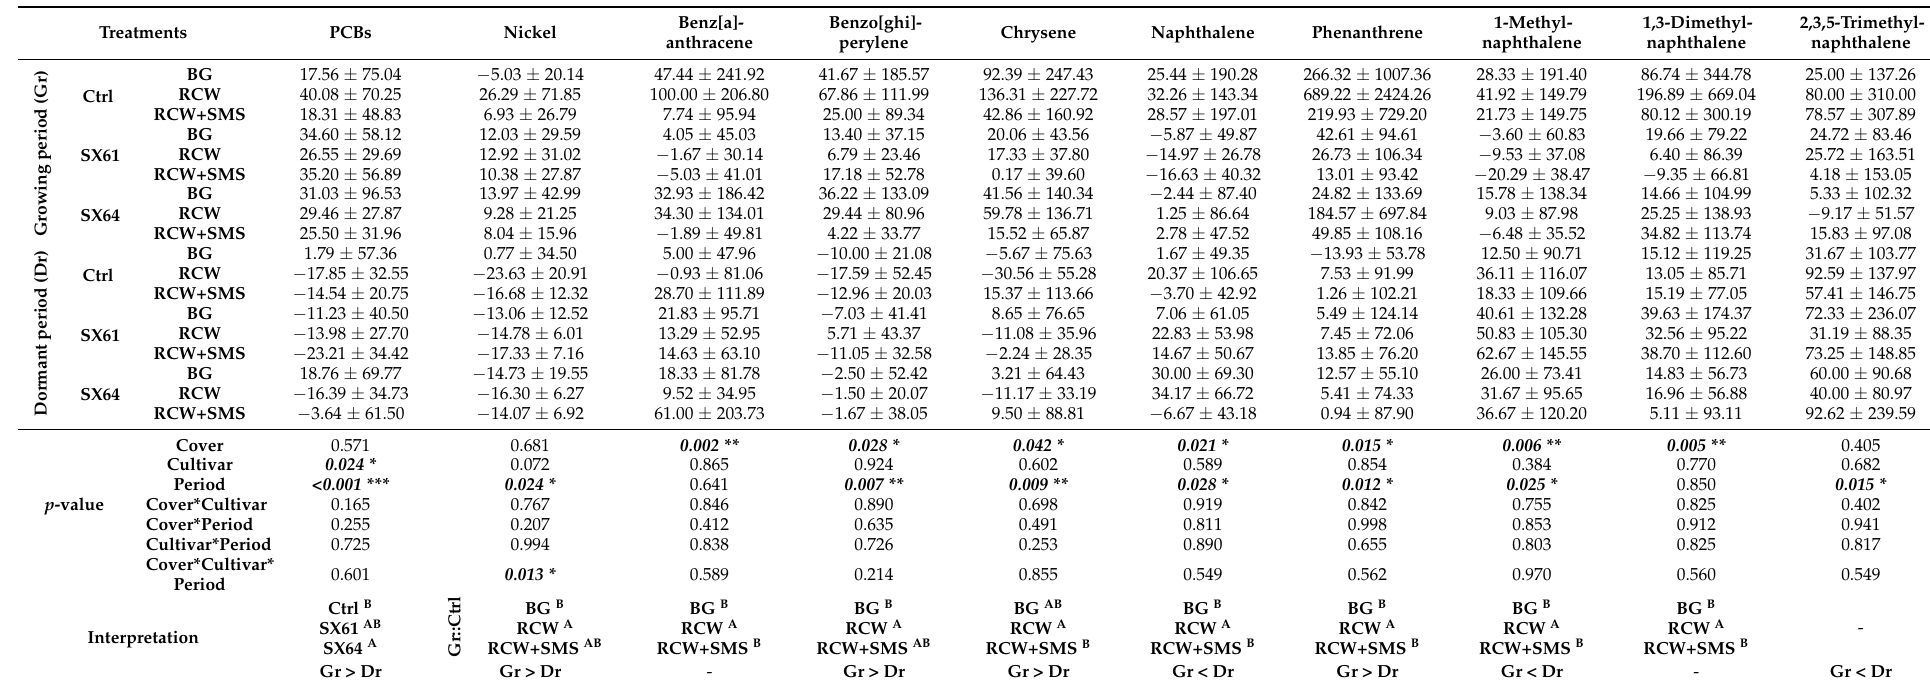
Table 3. Seasonal variation (SV) of soil PCBs, nickel and eight